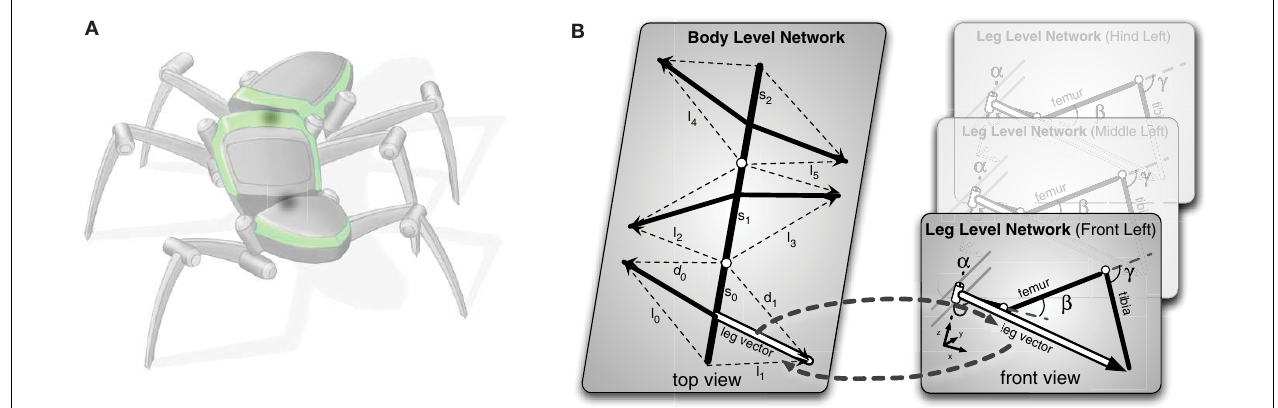
network shares the end point vectors with the higher body level network. During processing both levels mutually inform each other. In the inverse kinematic case the body level produces new leg vectors as target vectors that are forced onto the leg network, which comes up with corresponding joint angles for the target